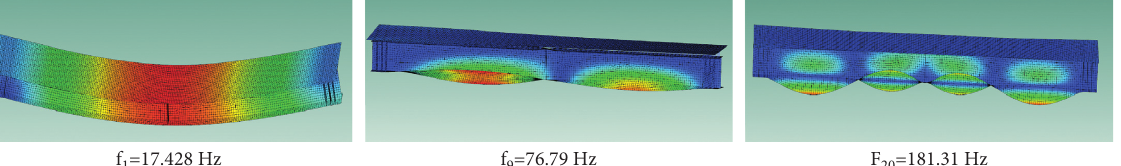
Figure 7: Several vibrational modes.